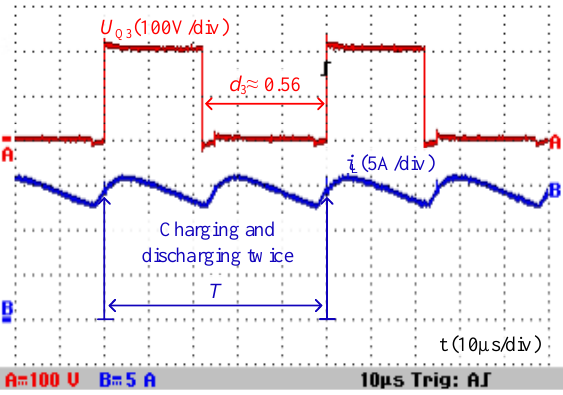
17 of 22 Figure 15. The output voltage and the wide-range changed input voltage from 25 V to 60 V in step- up mode. 4.2. Experimental Results in the Step-Down Mode Figures 16 and 17 show the voltage waveforms of power semiconductors in the step-down operation mode. According to Figures 16 and 17, the PWM voltage of each power semiconductor is about 200 V, approximately equaling the high-voltage side U high . The voltage gain M Buck of the proposed converter is 1/8 and the duty cycle d Buck is about 0.56. The ON state time of the power switches Q 3 – Q 5 is about 0.56 T and the ON state time of the power switches Q 1 – Q 2 is about 0.44 T. At that high voltage conversion ratio, both the ON and OFF state times of those power switches are close to 0.5 T, which is effective for avoiding the narrow pulse of the PWM voltage waveforms. In addition,